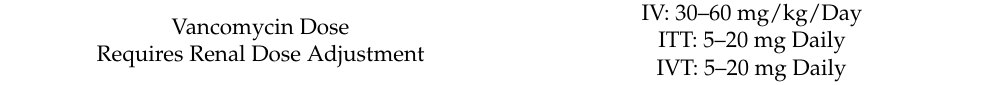
Table 2. Vancomycin dosing and PK/PD data.